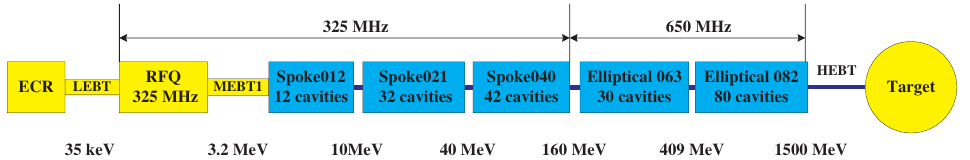
FIG. 3. Schematic layout of the MOMENT driver